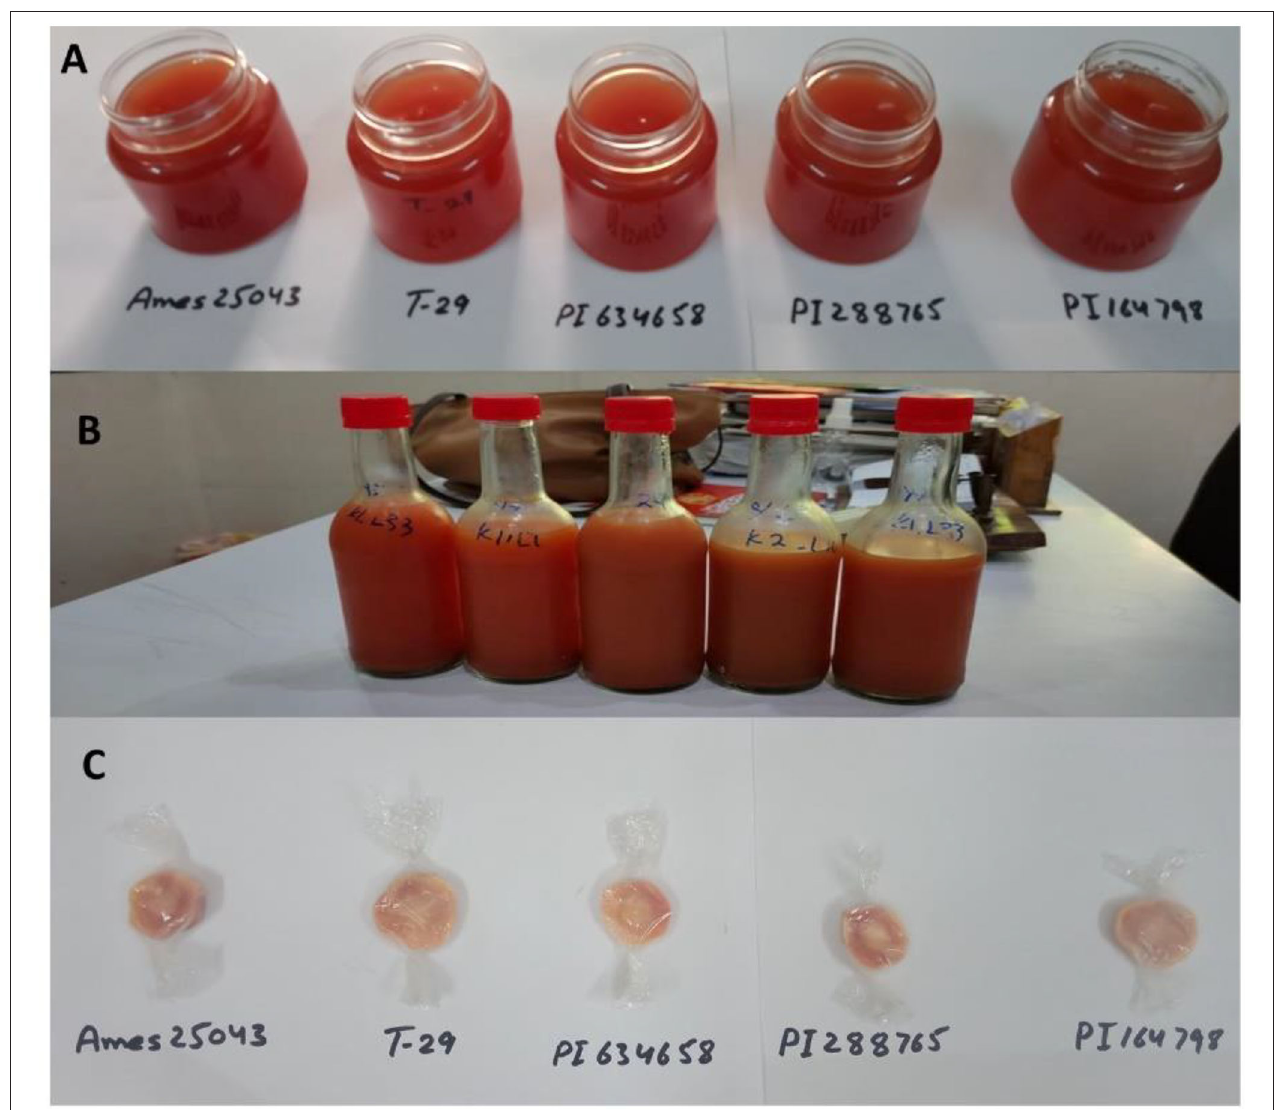
FIGURE 6 | Carrot nutraceutical products i.e., (A) Carrot Jam, (B) Carrot mix juice, and (C) Carrot